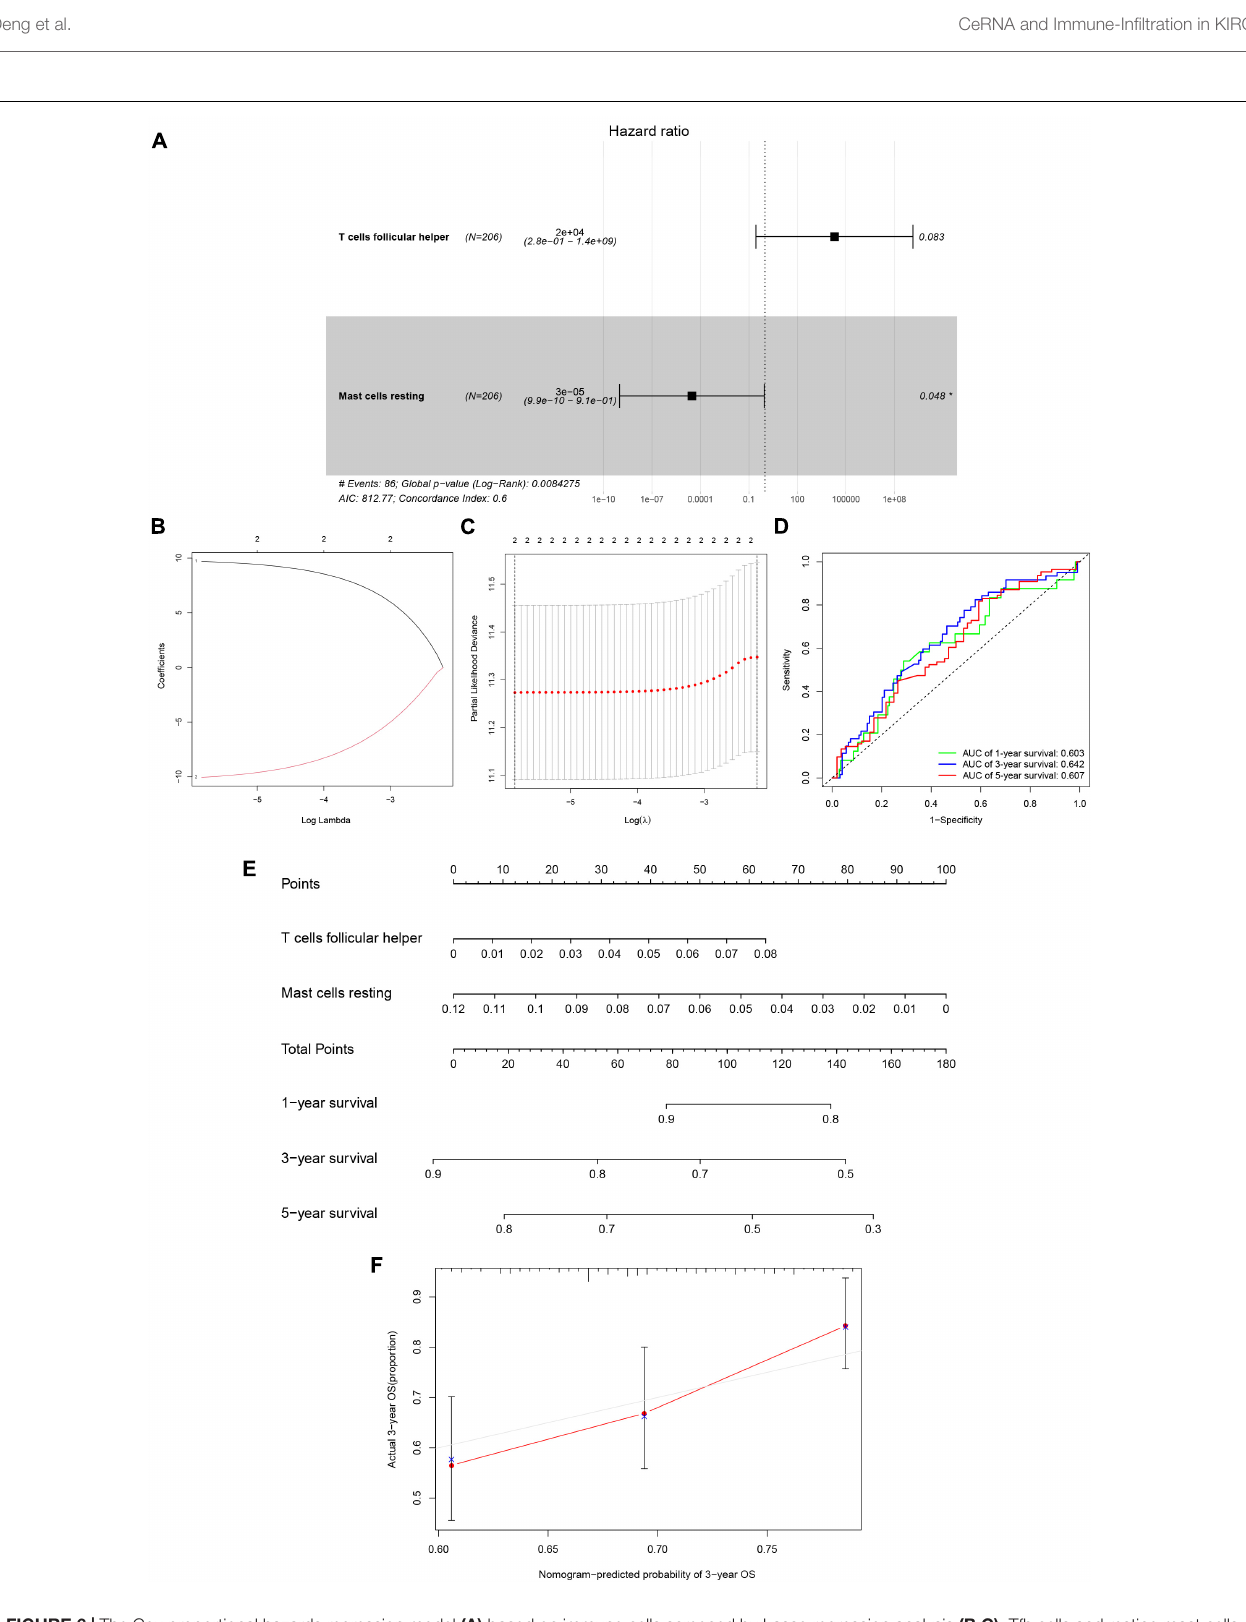
Frontiers in Genetics |